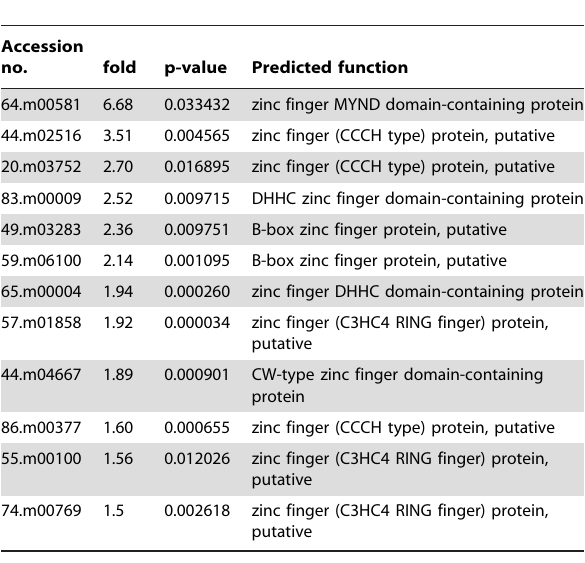
Table 1. Predicted zinc finger proteins up-regulated during alkaline stress in Toxoplasma.